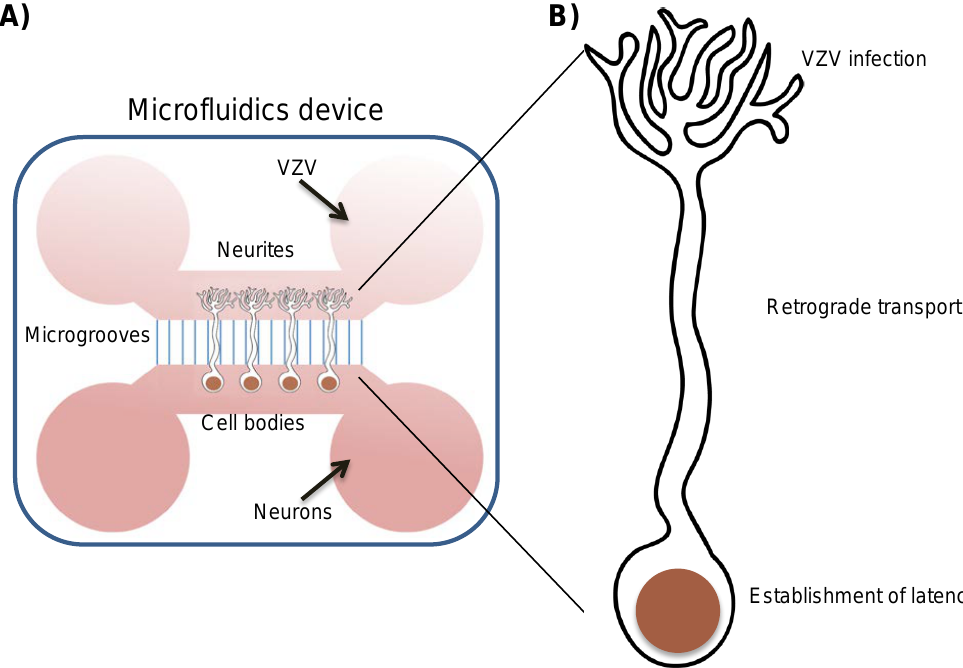
Figure 3. Establishment of VZV latency using microfluidic devices (based on [74,76]). ( A ) Cartoon showing a representation of a microfluidic device to separate the neuronal cell bodies from the neurites. Dissociated neurons are seeded in one of the chambers and growth factors are added in the opposite one inducing neurite outgrowth through the microgrooves. Before infection a pressure gradient is generated by increasing the volume of medium in the cell body compared to the neurite